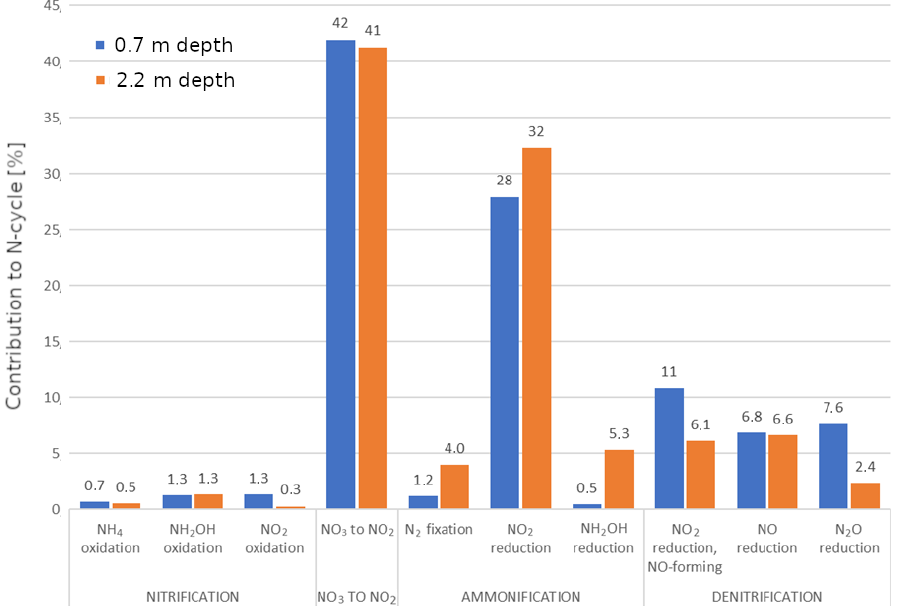
Figure 5. Contribution of bacterial communities to nitrogen transformation processes in the peat layer at depths of 0.7m (sub-oxic) and 2.2m (anoxic) in Nagele, March